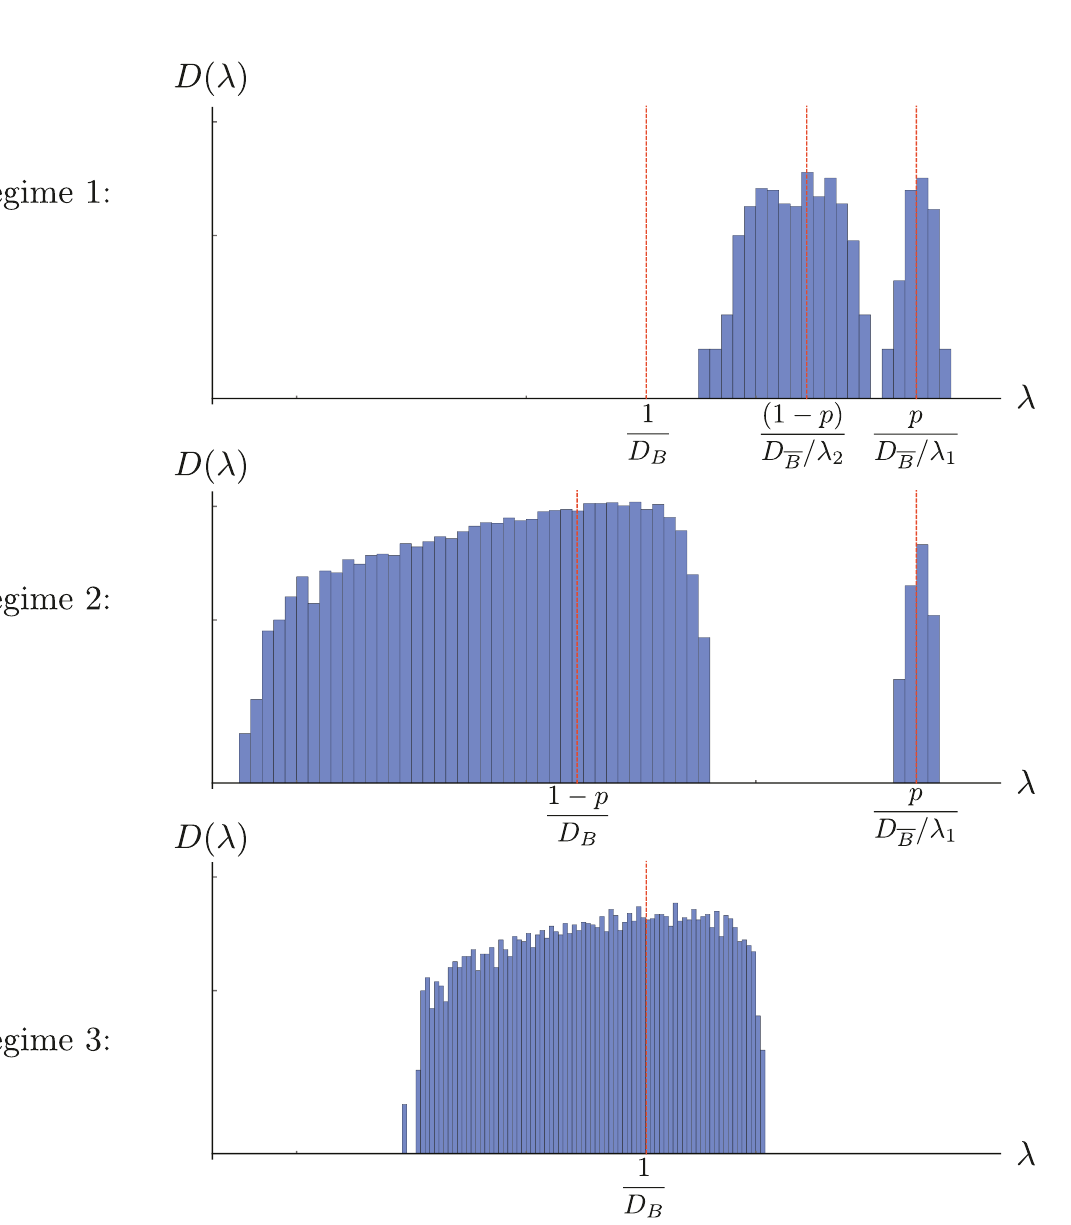
Figure 9 . Log-log histogram of the eigenvalue density D ( λ ) of ρ B , for a random tensor with two “boundary” legs B, B and a “bulk” leg b 0 , for 80 trials. All plots are made with boundary leg dimensions D = 30 , D = 1 and bulk leg state (C.1), with p = 1 / 2 . Regime 1 plot made with B B λ 1 = 1 , λ 2 = 1 / 3 ; Regime 2 plot λ 1 = 1 , λ 2 = 1 / 45 ; Regime 3 plot λ 1 = 1 / 20 , λ 2 = 1 / 45 . Note the agreement with figure